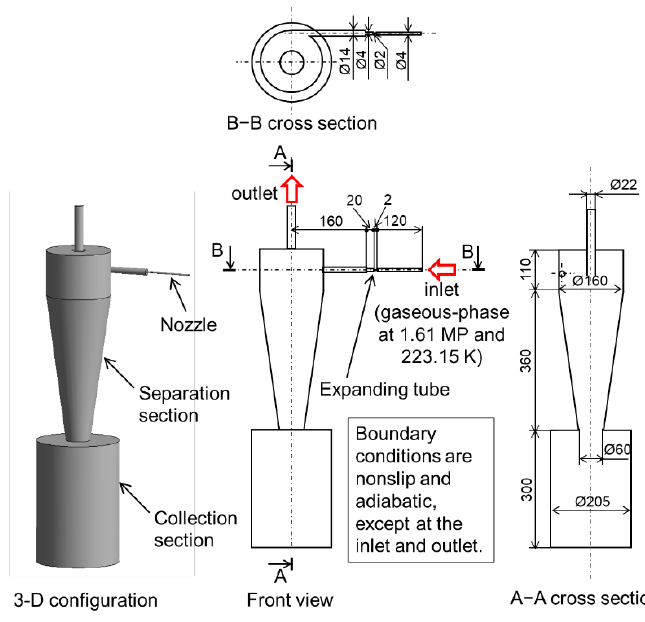
Figure 5. Three-dimensional flow field configuration and schematic diagram of the model.